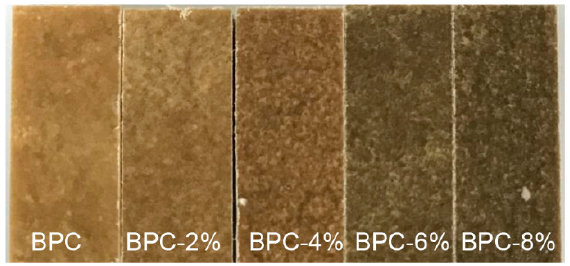
Figure 6. Images of the BPC samples made with different contents of HNTs.